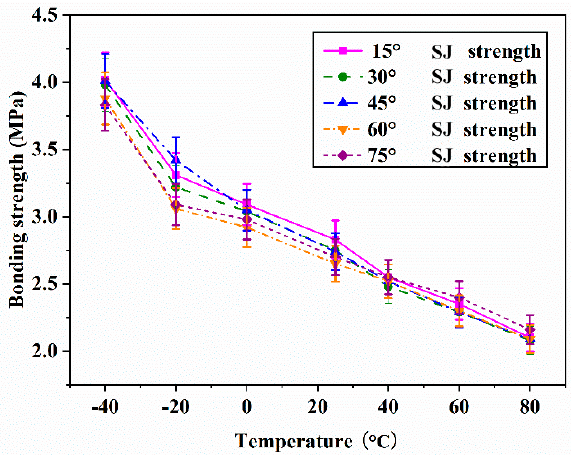
◦ , 30 ◦ , 45 ◦ , 60 ◦ , 75 ◦ SJ strength as a function of Figure 11. Average 15°, 30°, 45°, 60°, 75° SJ strength as a function of temperature. Figure 11. Average 15